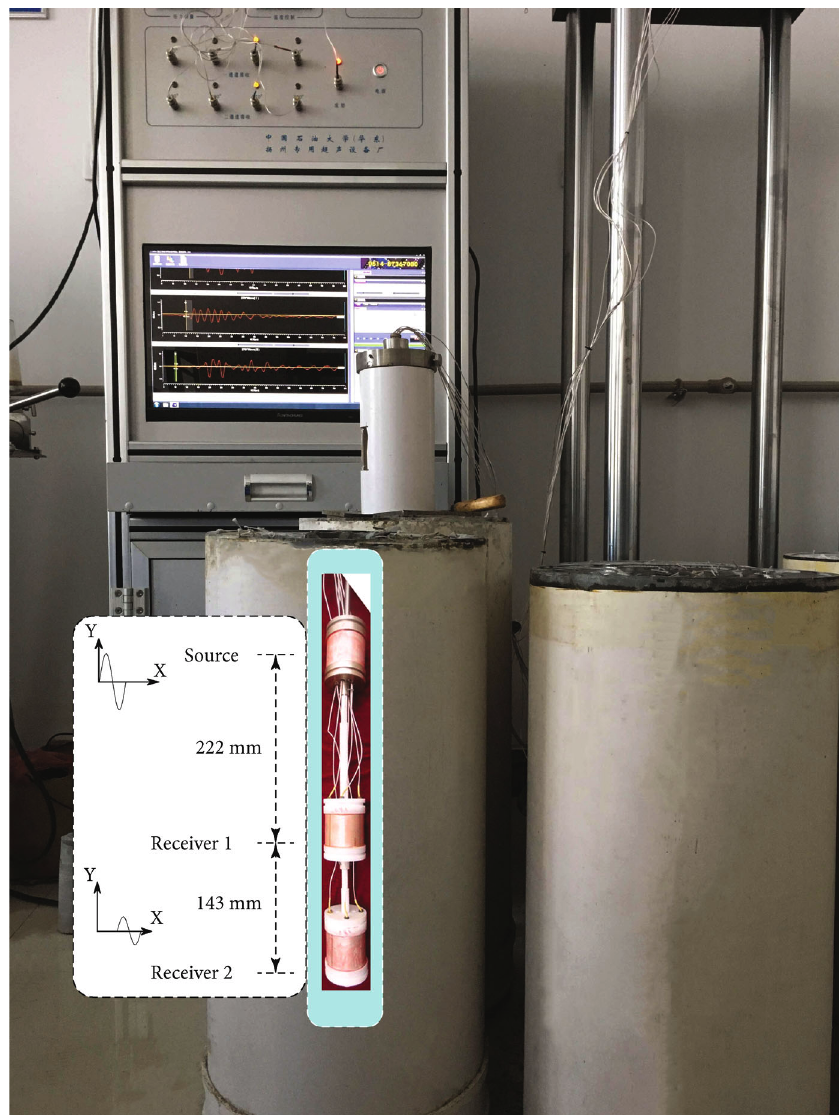
Figure 4: The homemade acoustic logging system with one source and two receivers.